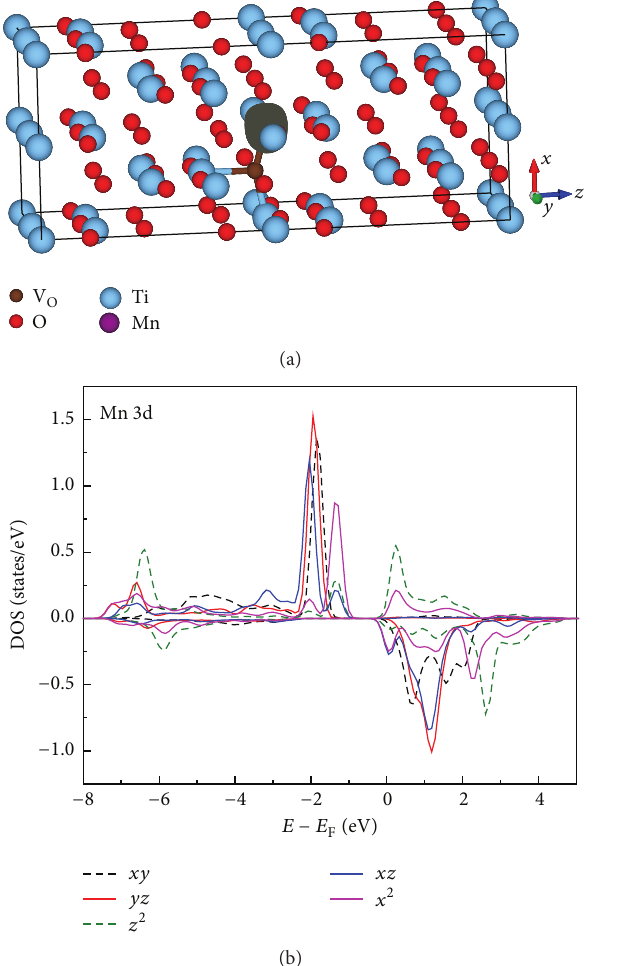
Figure 3: Isosurface plot of magnetization density (majority-spin minus minority-spin) for (a) Ti 31 MnO 63 supercell; (b) the orbitally decomposed density of states projected on Mn ion.